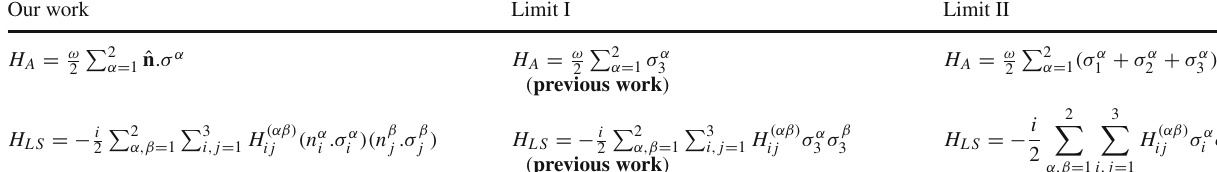
Table 1 Comparison between our work and previous works Our work